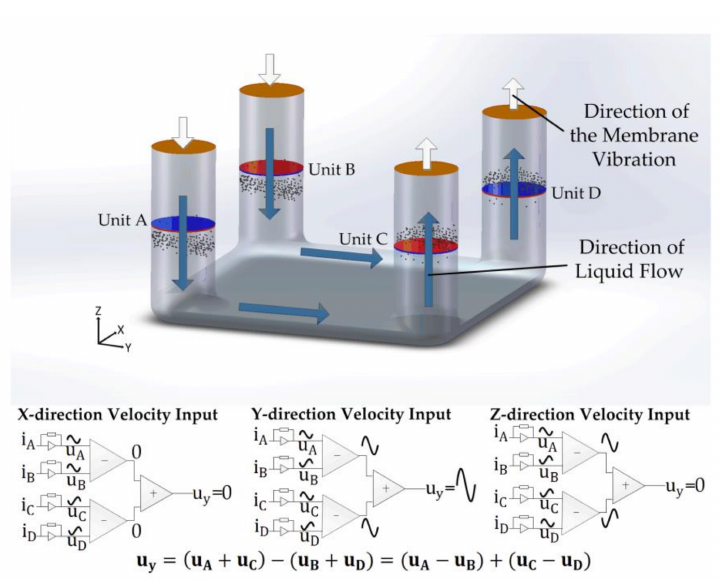
Figure 3. Sensing mechanism illustrations and schematics of fluid flowing mechanism in response to acceleration along y -axis. Blue arrows represent the direction of liquid flow due to the convection caused by the external vibration while white arrows represent the direction of the membrane vibration.